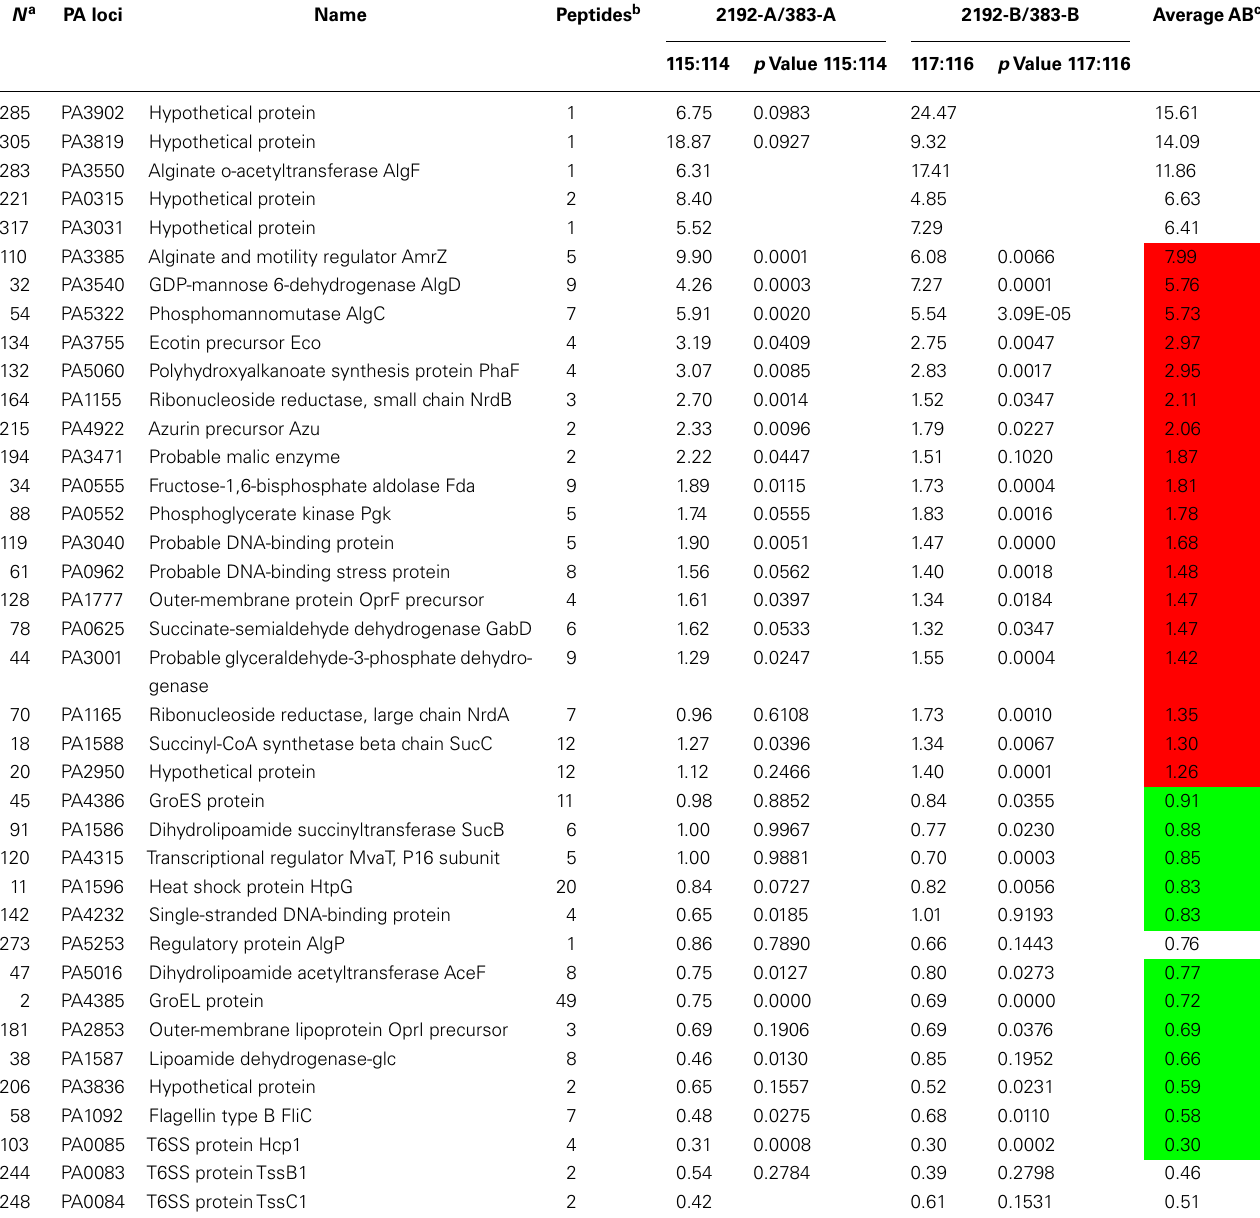
Table 2 | Selected proteins with differential expression between strains 383 and 2192 as observed by iTRAQ analysis. N